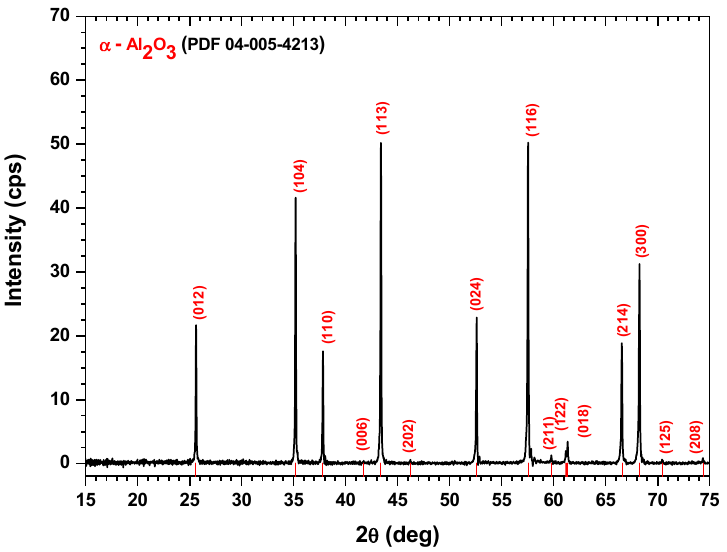
Figure 1. X-ray diffraction pattern of the alumina bulk sample and the diffraction lines’ positions, shown with red color, according to the PDF-04-005-4213 reference file.